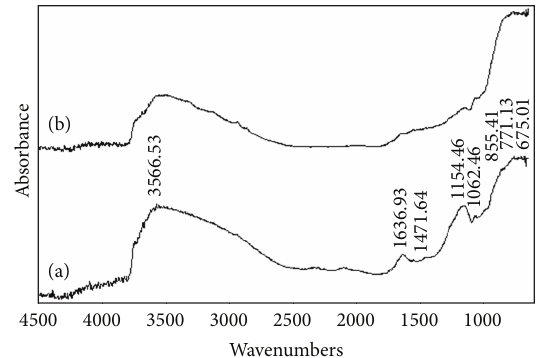
Figure 4: DRIFT spectra of (a) Al CCo10% , (b) Al CBo10% , and (c) Al C1000